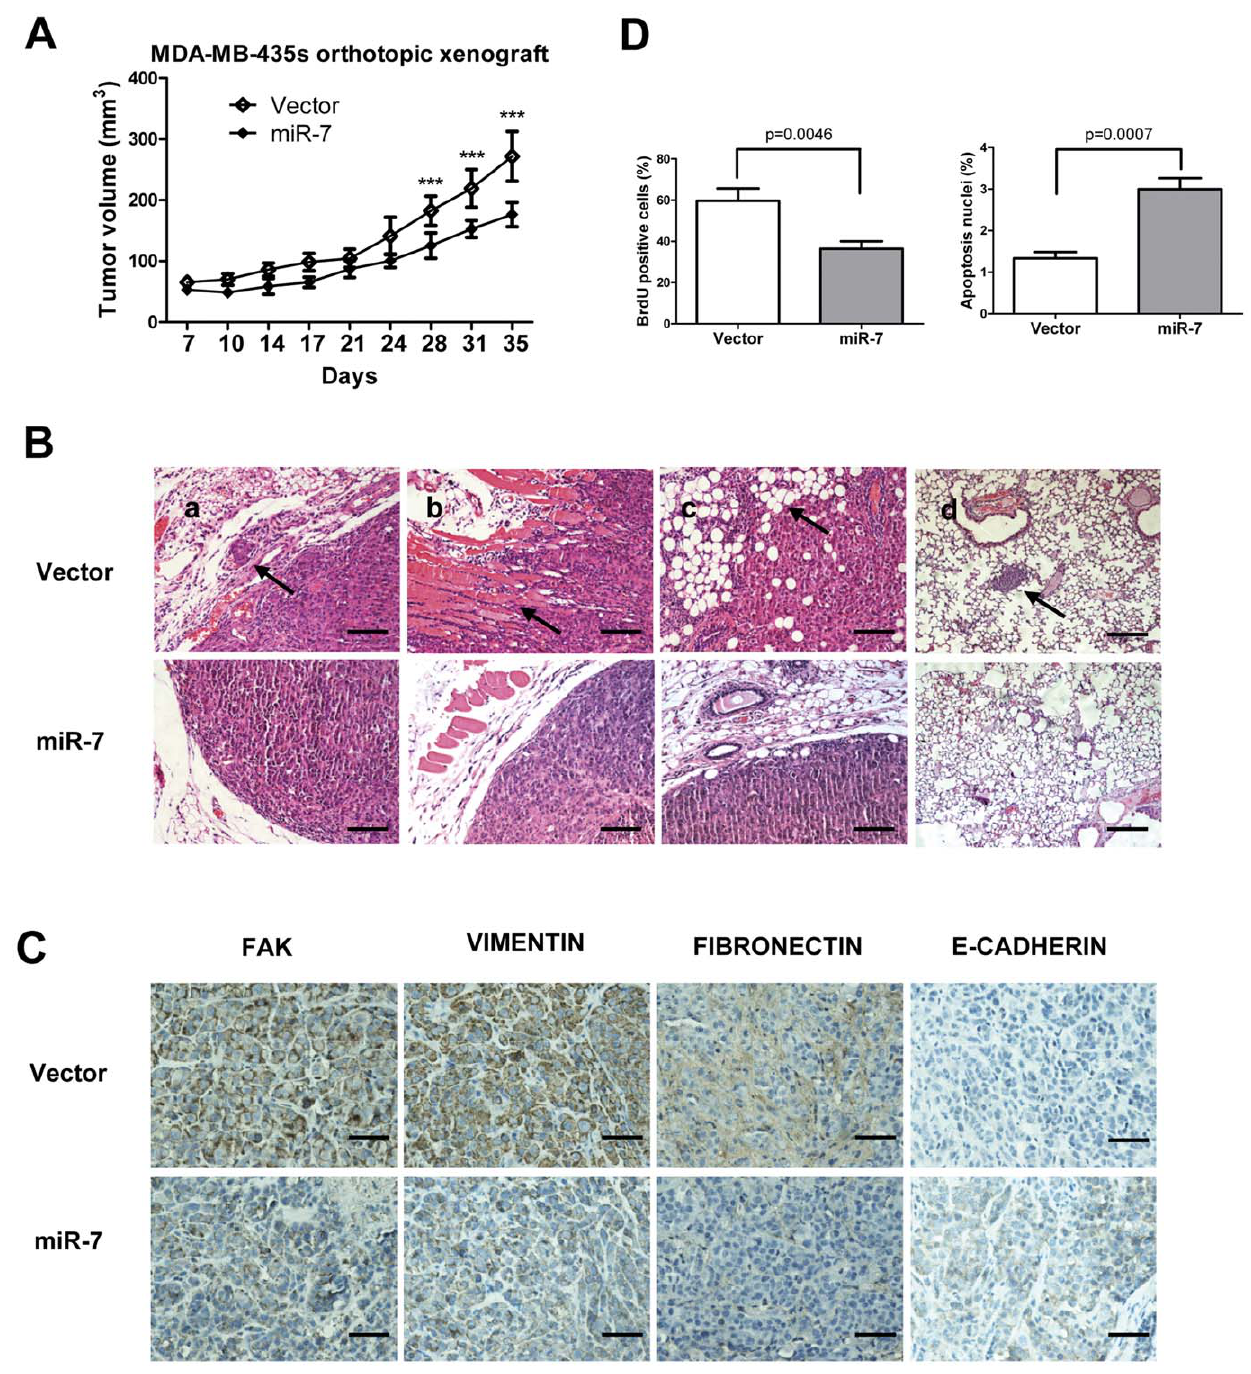
Figure 6. miR-7 inhibits breast cancer cell growth, local invasion invivo . (A) Primary tumor growth upon orthotopic injection of 1.0 6 10 6 MDA-MB-435s cells infected as indicated. n=12 per group per time point. (B) H&E staining of primary tumors and mice lungs after orthotopic injection. Arrows: tumor cells venous (a), muscle (b) invasion and lung metastasis foci (d). (scale bar: 100 m m) (C) FAK, VIMENTIN, FIBRONECTIN, E- CADHERIN stained primary tumors after orthotopic injection. Arrow indicate metastatic foci (scale bar: 50 m m). (D) Evaluation of nuclear BrdU incorporation and TUNEL positive (apoptotic) nuclei in MDA-MB-435s tumors. ***, p , 0.001.